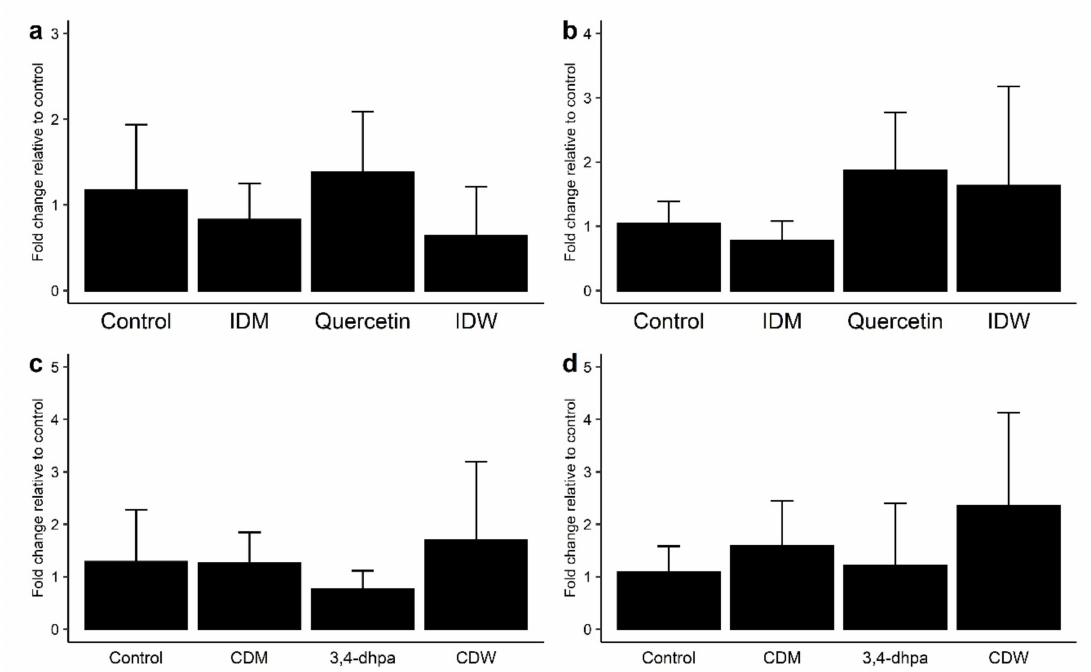
Figure 3. Effect on ZO-1 ( a,c ) and occludin ( b,d ) expression in Caco-2 cells of ( a ) intestinal digestion medium (IDM), quercetin (200 µ M) and intestinal-digested wine (IDW) after 4 h of incubation, and ( b ) colon digestion medium (CDM), dihydroxyphenylacetic acid (200 µ M) and colonic-digested wine (CDW) after 16 h of